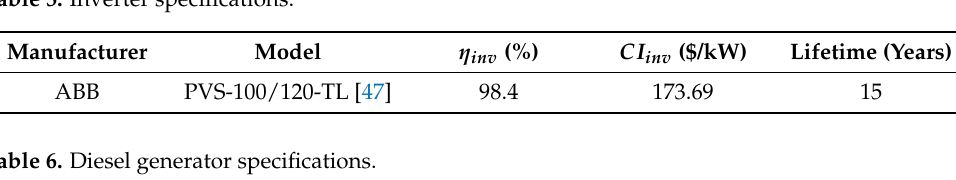
Table 5. Inverter specifications.